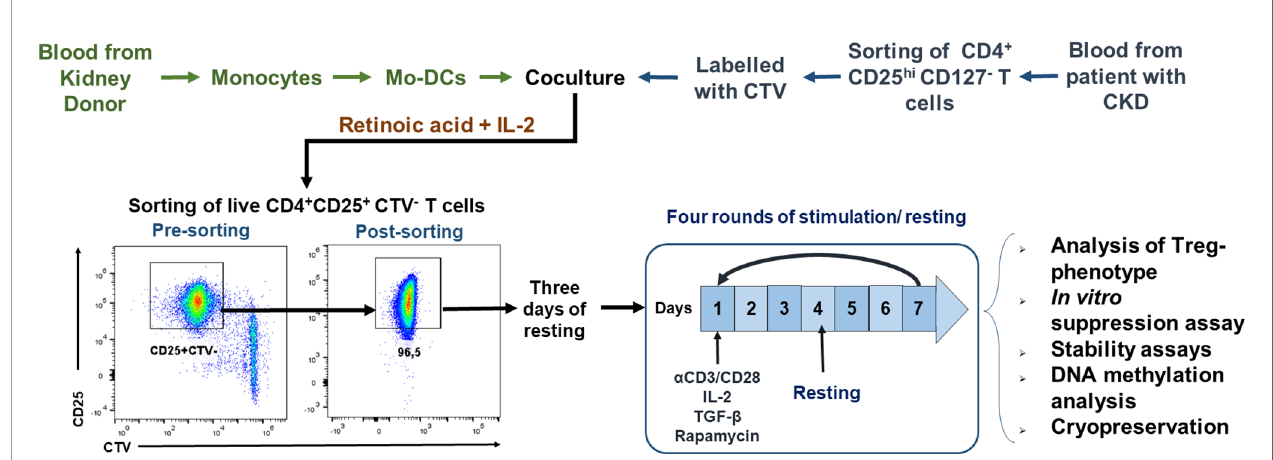
FIGURE 1 | Schematic representation of the protocol used for ex vivo expansion of alloantigen-speci fi c regulatory T cells (Tregs). CD4 + CD25 hi CD127 − T cells [labeled with CellTrace Violet (CTV)] sorted using fl uorescence-activated cell sorting (FACS) were stimulated with allogeneic monocyte-derived dendritic cells (Mo- DCs) in the presence of IL-2 and retinoic acid. On day 7, CD4 + CD25 hi CTV − T cells (allospeci fi c Tregs) were puri fi ed by FACS, rested for 3 days, and then polyclonally expanded for 4 days stimulated with anti-CD3/anti-CD28, IL-2, TGF- b , and rapamycin, followed by 3 days resting with only IL-2. After four rounds of polyclonal expansion, analysis of the phenotype and in vitro functional assays were